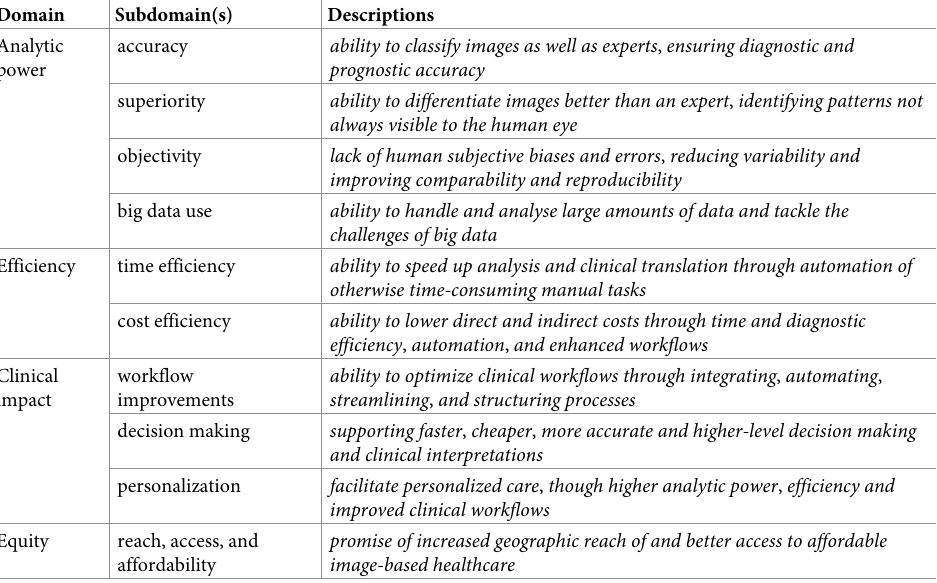
Table 2. Reported (expected) strengths and promises of image-based machine learning.